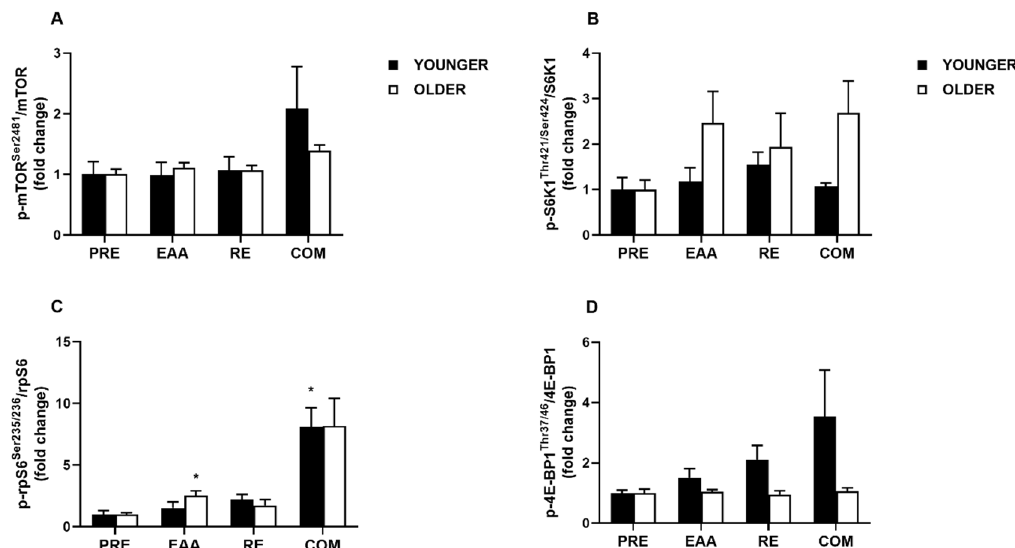
Figure 4. Phosphorylation of mTOR at Ser2481 ( A ), S6K1 at Thr421 / Ser424 ( B ), rpS6 at Ser235 / 236 ( C ), and 4E-BP1 at Thr37 / 46 ( D ) following EAA, RE, and COM in healthy younger ( n = 7) and older ( n = 7) adults. The symbol ( * ) denotes statistical significance compared to baseline. Data are means ± SEM.